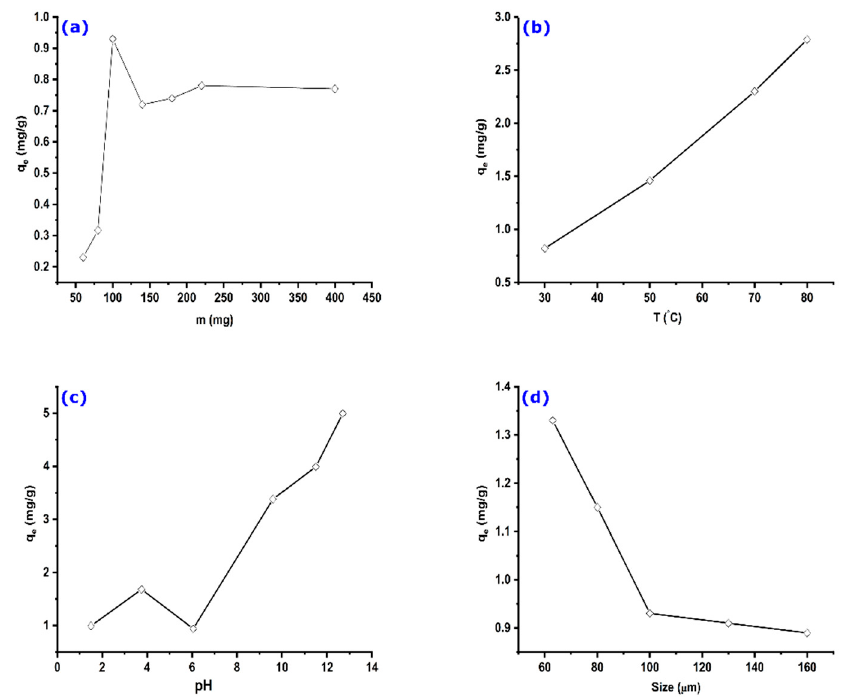
Figure 5. The effect of different parameters on the adsorption capacity of AS: ( a ) adsorbent mass, ( b ) temperature, ( c ) pH, and ( d ) AS particle diameter. Experimental conditions: C 0 = 32.7 mg/g, m = 100 mg, V = 25 mL, T = 25 °C, pH = 6.